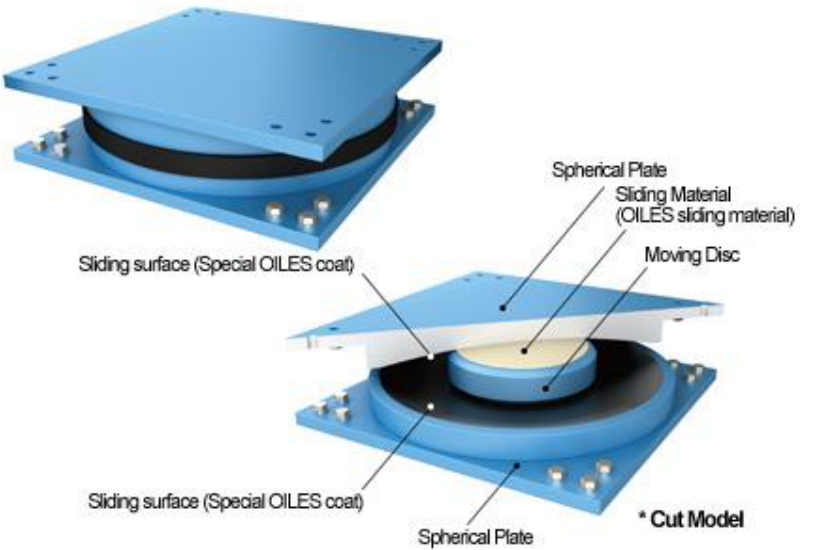
Figure 2. Friction Pendulum Bearing. Source: [33].